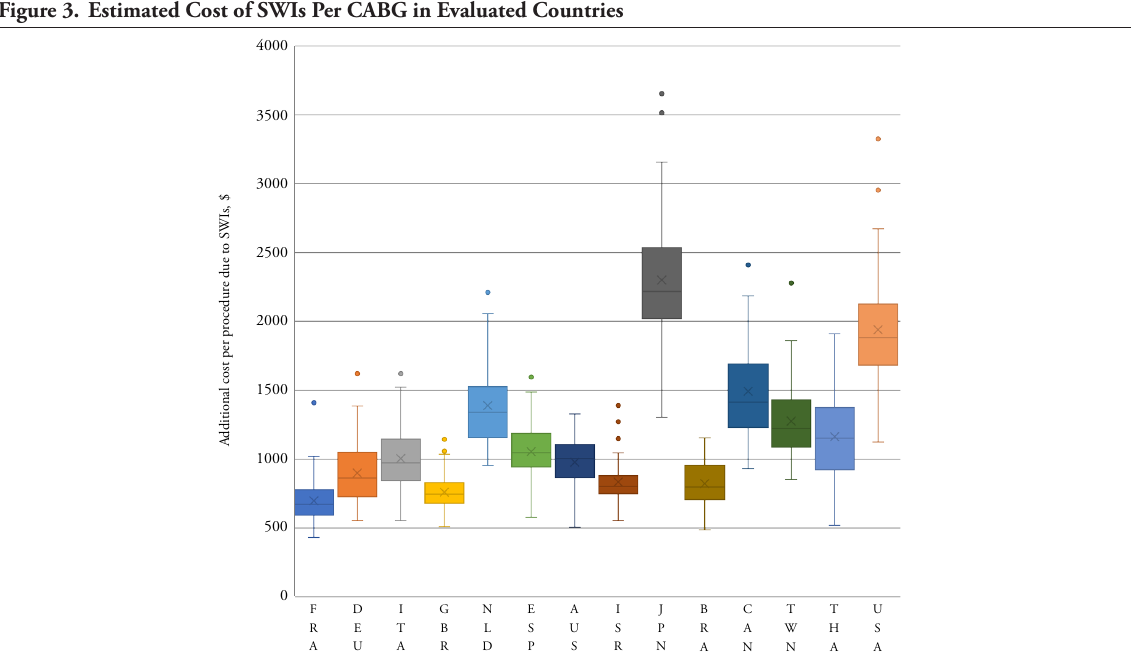
Figure 3. Estimated Cost of SWIs Per CABG in Evaluated